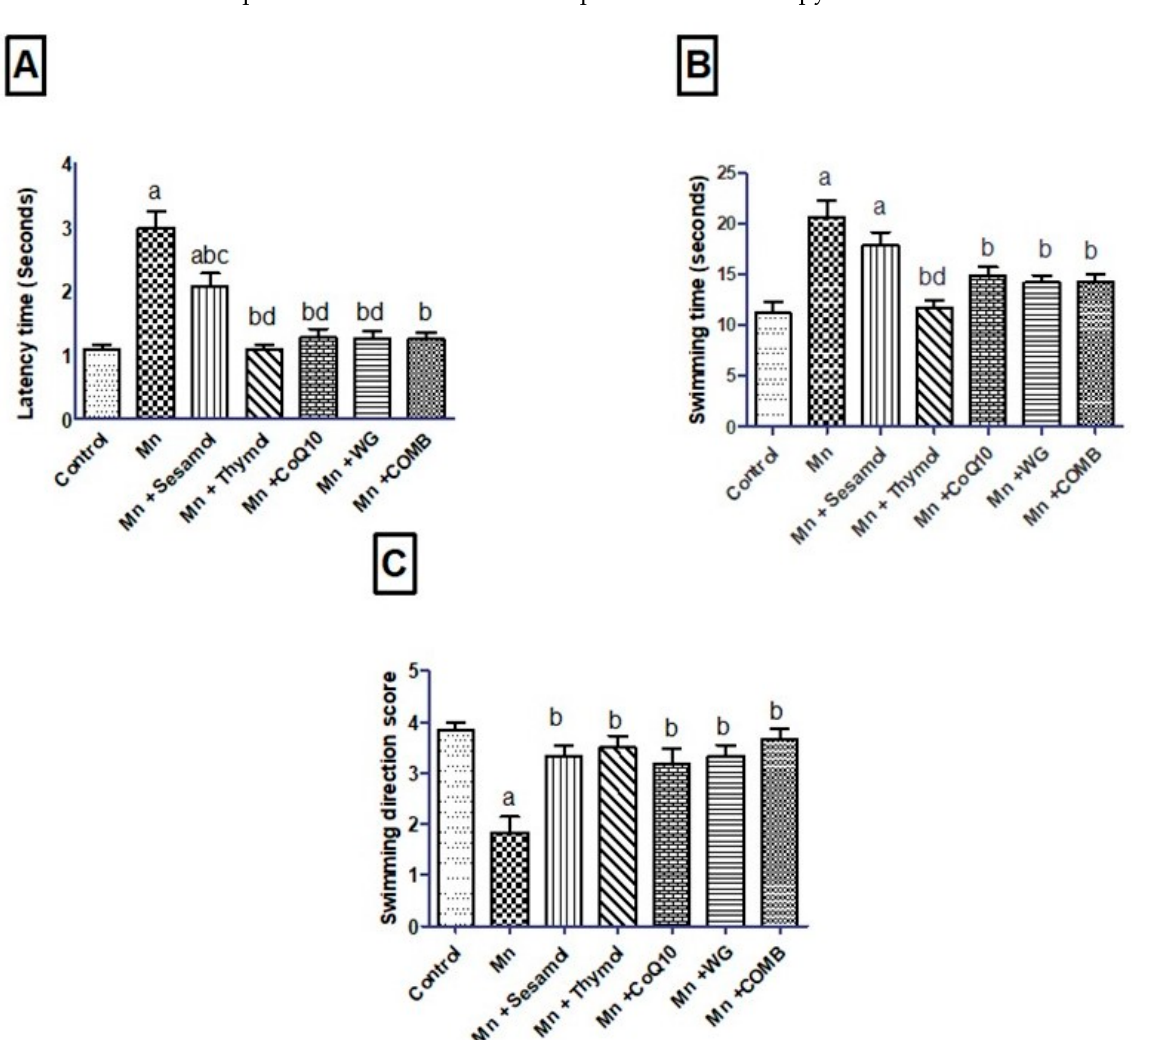
Figure 2. Effects of sesamol, thymol, CoQ10, wheat grass, or their combination on swimming test of rats treated with MnCl 2 . ( A ) latency time, ( B ) swimming time, and ( C ) swimming direction score. Values are means of 12 rats ± S.E.M, as compared with control (a), Mn (b), COMB (c), and sesamol (d) groups. One-way ANOVA with posttest Tukey’s multiple comparison assessed the statistical differences between the various groups, p -value < 0.05.